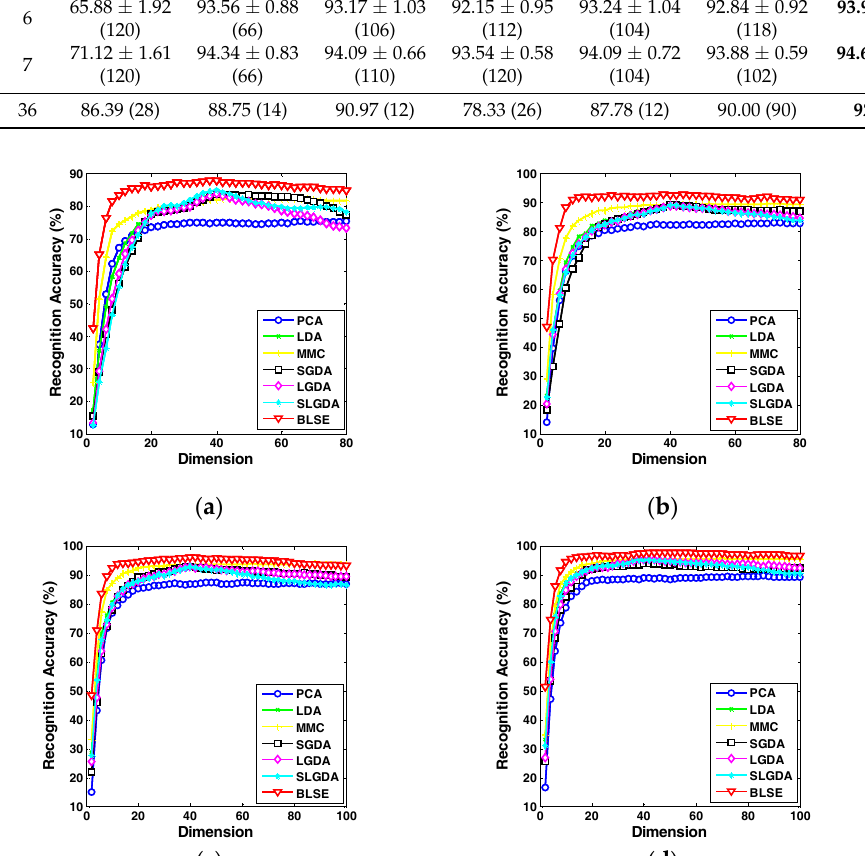
Figure 9. Recognition rate (%) versus dimension of different methods on the ORL database. ( a ) Three training samples per person; ( b ) Four training samples per person; ( c ) Five training samples per person; ( d ) Six training samples per person.